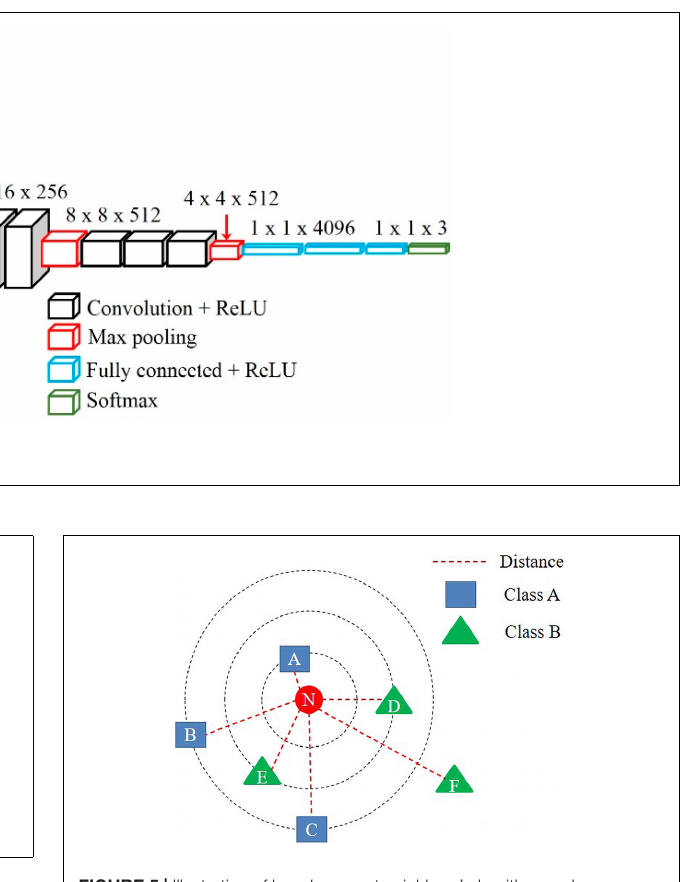
FIGURE 5 | Illustration of how k -nearest neighbors’ algorithm